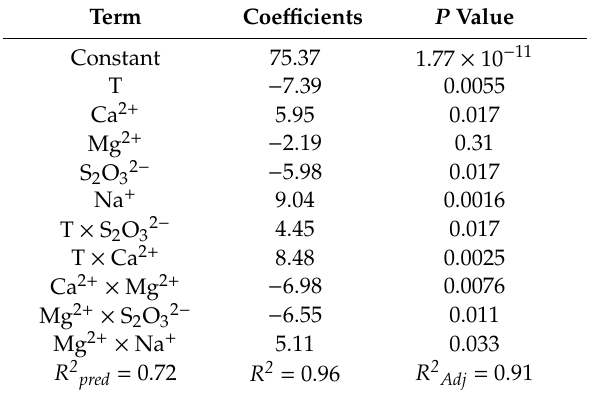
Figure 4. The e ff ect of water constituents and the interaction on xanthate adsorption on a pentlandite concentrate. Error bars a calculated based on 95% confidence intervals. Insignificant terms with error bars spanning the positive and negative y axis must be removed from the final regression model. Table 6. Final regression coe ffi cients for collector adsorption on pentlandite.